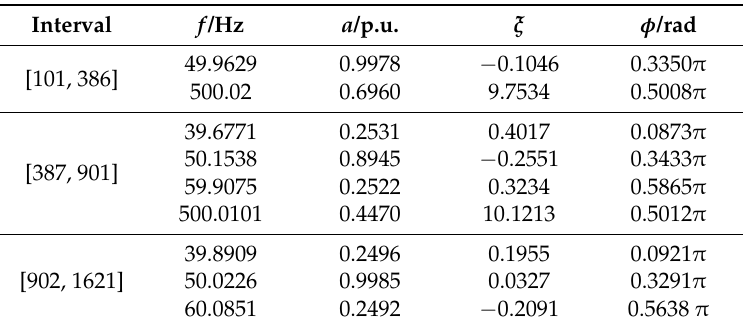
Table 1. Parameters identification of Equation (18).